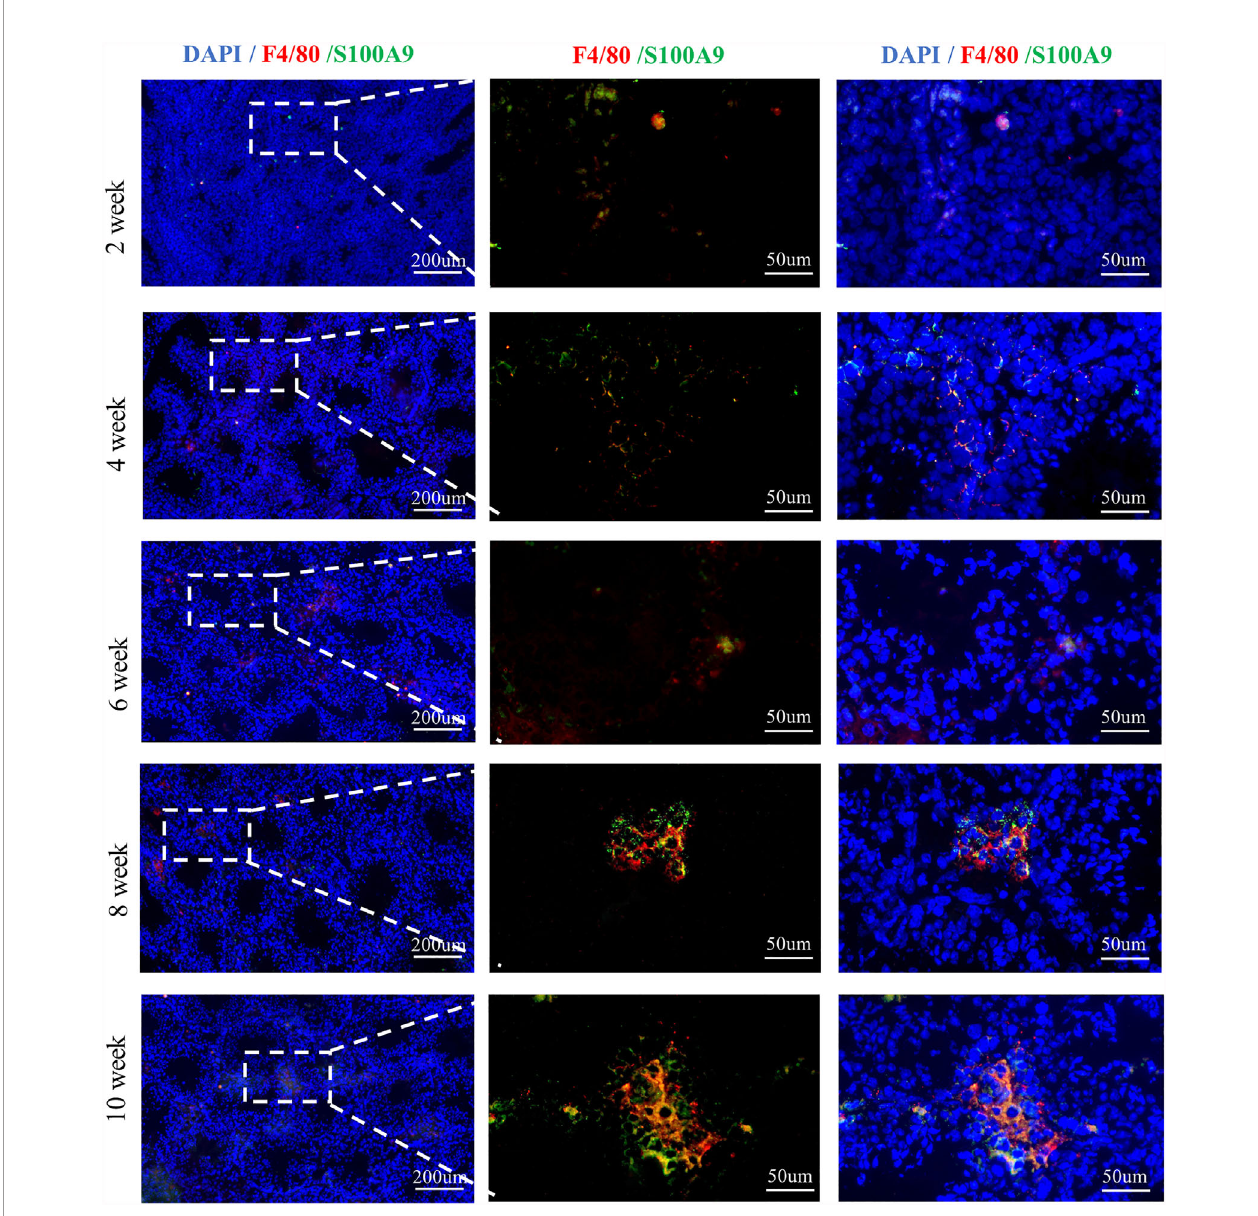
FIGURE 1 | S100A9 expressed in testicular macrophages of mouse from weeks 2 to 10. Double immuno fl uorescence staining of S100A9 and mouse macrophage marker (F4/80) in testis from weeks 2 to 10 (scale bar: 200 and 50 m